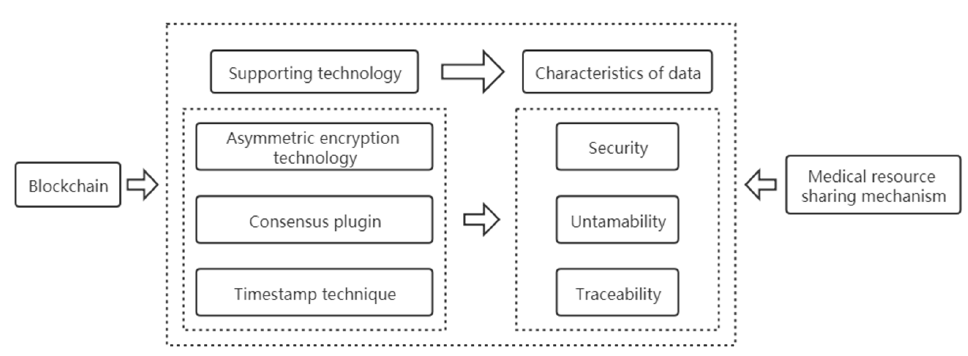
Figure 5. Transaction mechanism coupling analysis.